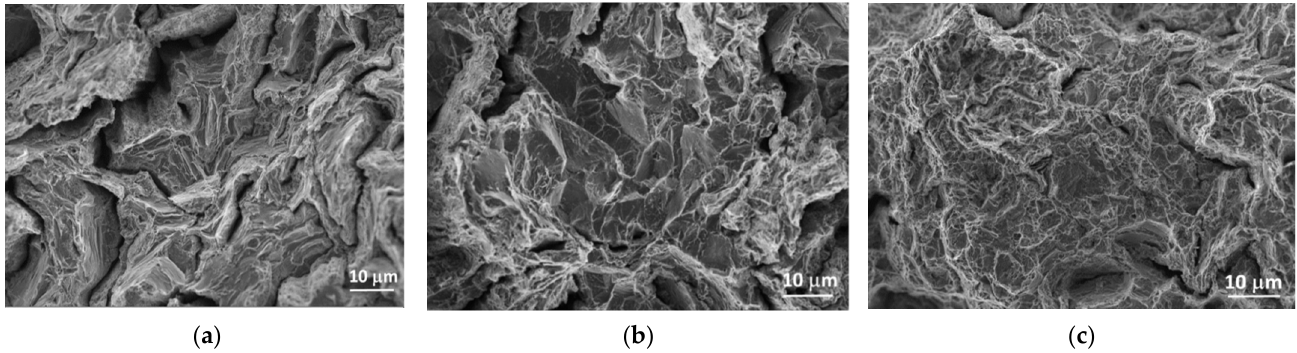
Figure 10. Fracture surface morphology of tensile failure samples: ( a ) Mg, ( b ) Mg-3Sn, and ( c ) Mg-3Sn + 0.2 GNP.